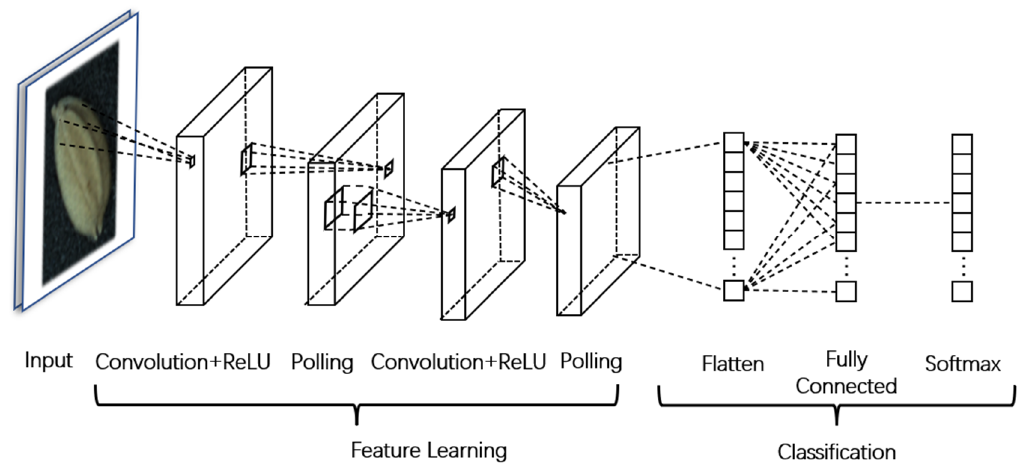
Figure 5. CNN network